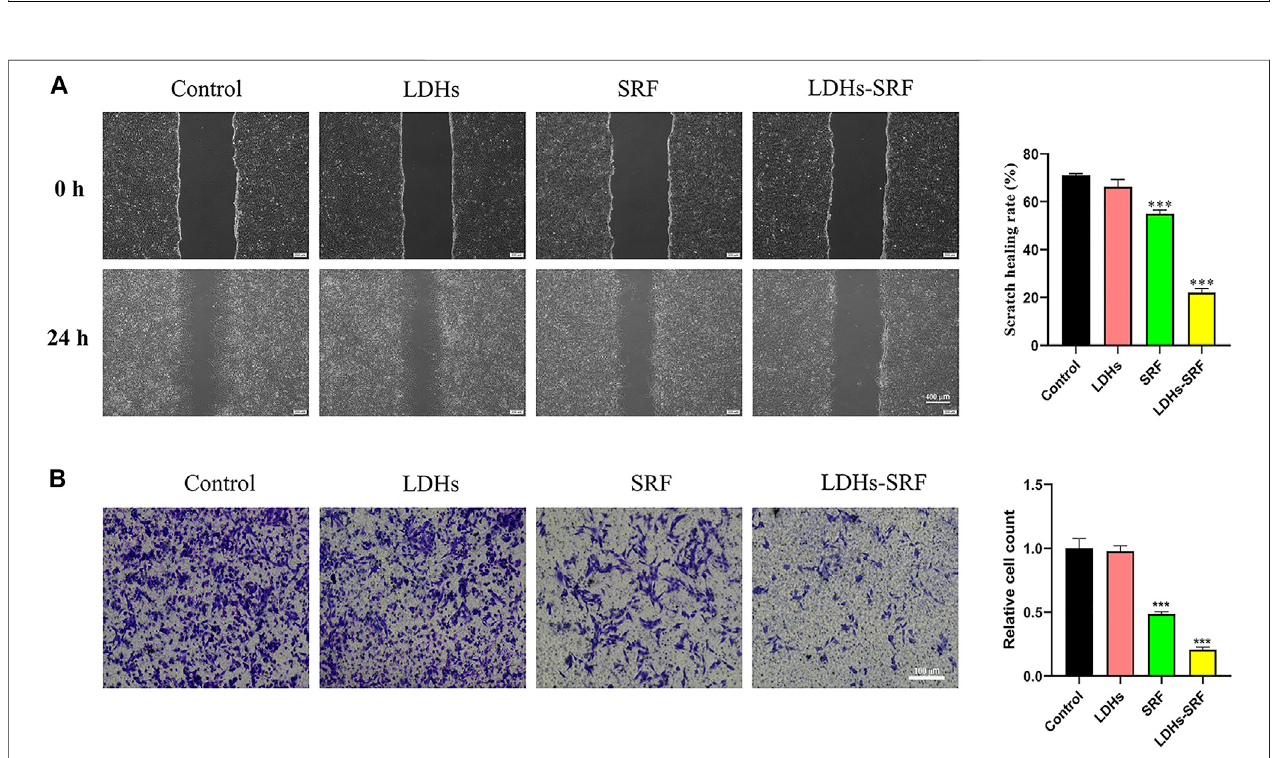
FIGURE 4 | Effect of 10 μ M SRF and LDHs-SRF on HSC-T6 cells migration capacity for 24 h. (A) Cell scratch test, the scale bar: 400 μ m; (B) Transwell test, the scale bar: 100 μ m. Data represent mean ± SD ( n = 3) and use one-way ANOVA with Tukey ’ s multiple comparison test, *** p < 0.001 vs. Control.